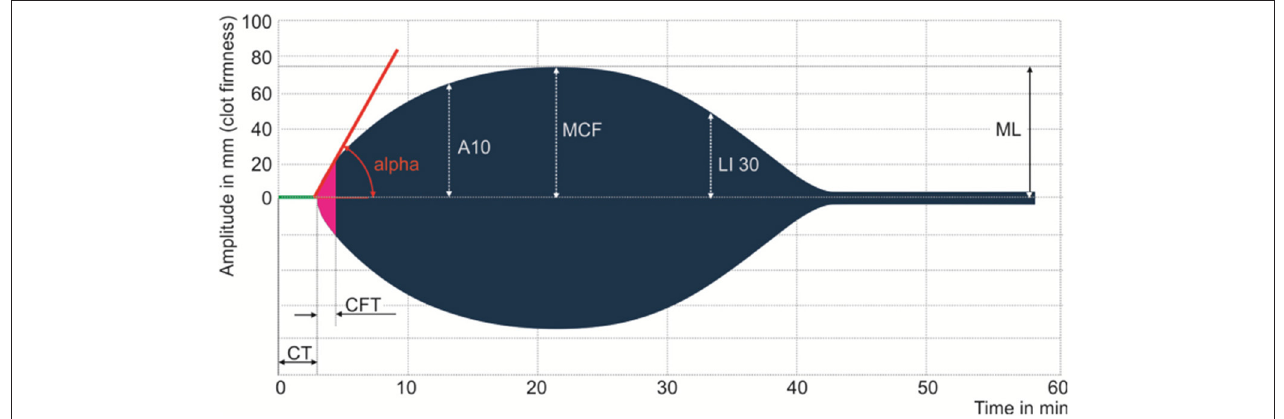
FIGURE 1 | Main parameters of the rotational thromboelastometry test. Clotting time (CT), clot formation time (CFT), alpha angle (ALP), the amplitude after 10 min after CT, maximum clot firmness (MCF), clot lysis index at 30min after CT (LI30), and maximum lysis